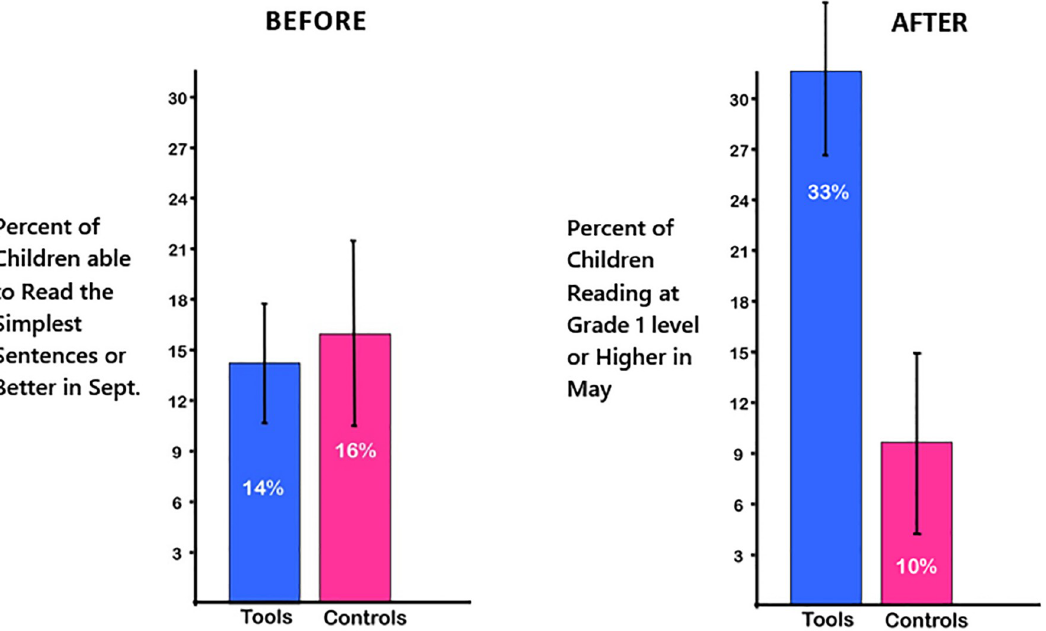
Fig 1. Reading skills. By May, three times as many children in Tools than in control classes were reading at Grade 1 level or better, although both groups started out comparably in the